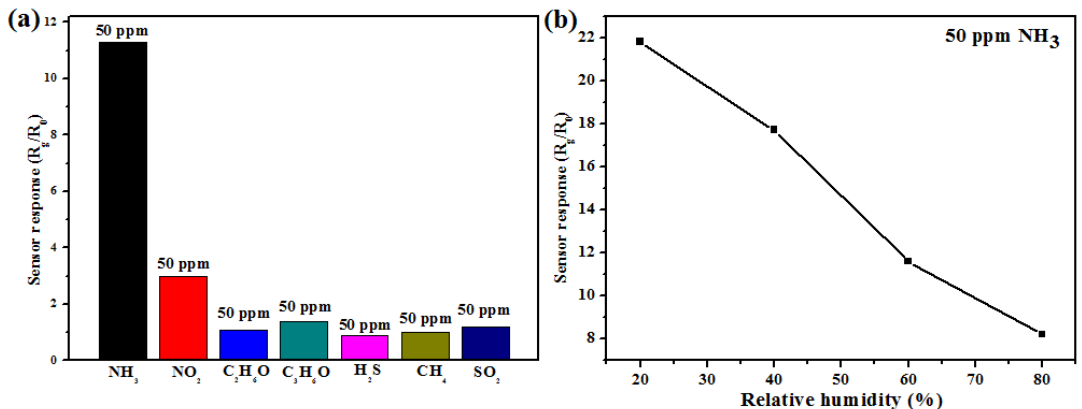
Figure 9. ( a ) The sensor responses of TiO 2 @PANI samples with m (TiO 2 )/m (Ani) = 2 to NH 3 (50 ppm), NO 2 (50 ppm), C 2 H 6 O (50 ppm), C 3 H 6 O (50 ppm), H 2 S (50 ppm), CH 4 (50 ppm) and SO 2 (50 ppm) at room temperature; ( b ) The influence of relative humidity to the performances of sensor to 50 ppm NH 3 at room temperature (between 20 and 80% of RH).